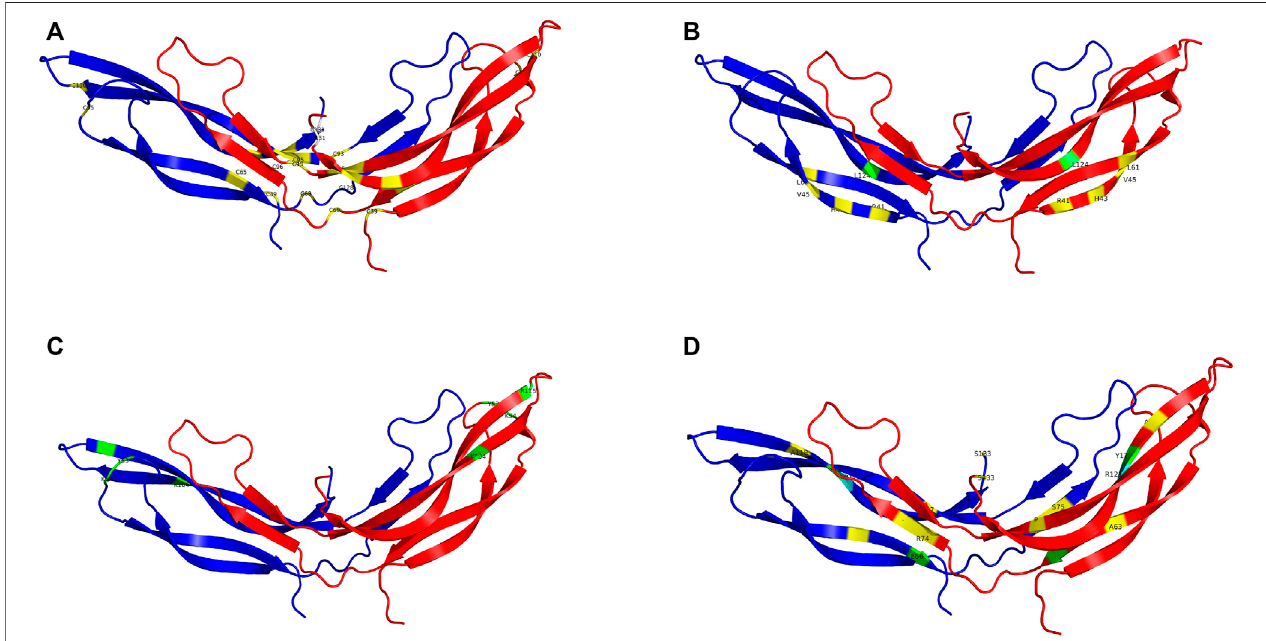
FIGURE 2 | The NDP homodimer is depicted in each panel with one molecule in blue and the other in red. (A) shows pathogenic variants in cysteine residues, (B) shows pathogenic variants at the FZD4 binding site, (C) shows pathogenic variants at the LRP5/6 binding site, (D) shows pathogenic variants at the dimer interface. Mutationsthatcausesevereretinopathyareshowninyellowwhilstthosethatcausemoderateretinopathyareshowningreen.Mutationsthatresultinaretinalphenotype of variable severity are shown in cyan. All molecular scale representations were prepared using the PyMOL Molecular Graphics System (Version 2.6.0a0, Schrödinger,LLC)[Schrodinger,LLCPyMOL(TM)MolecularGraphicsSystem,Version2.6.0a0].ThestructureofnorrinproteinwasfromtheProteinDataBank(PDBID = 5BQB) [Chang, T.-H, et al., Structure and functional properties of Norrin mimic Wnt for signaling with Frizzled4, Lrp5/6, and proteoglycan. eLife, 2015. 4: p.